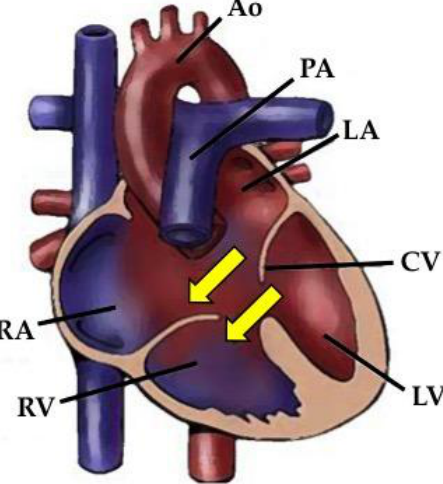
Figure 1. The diagram shows the complete form of AVCD with an ostium primum atrial septal defect, a ventricular septal defect, and a single common atrioventricular valve. The yellow arrows represent the left-to-right shunt through atrial and ventricular septal defects. RA: right atrium; RV: right ventricle; LA: left atrium; CV: common valve; LV: left ventricle; Ao: aorta; PA: pulmonary artery.